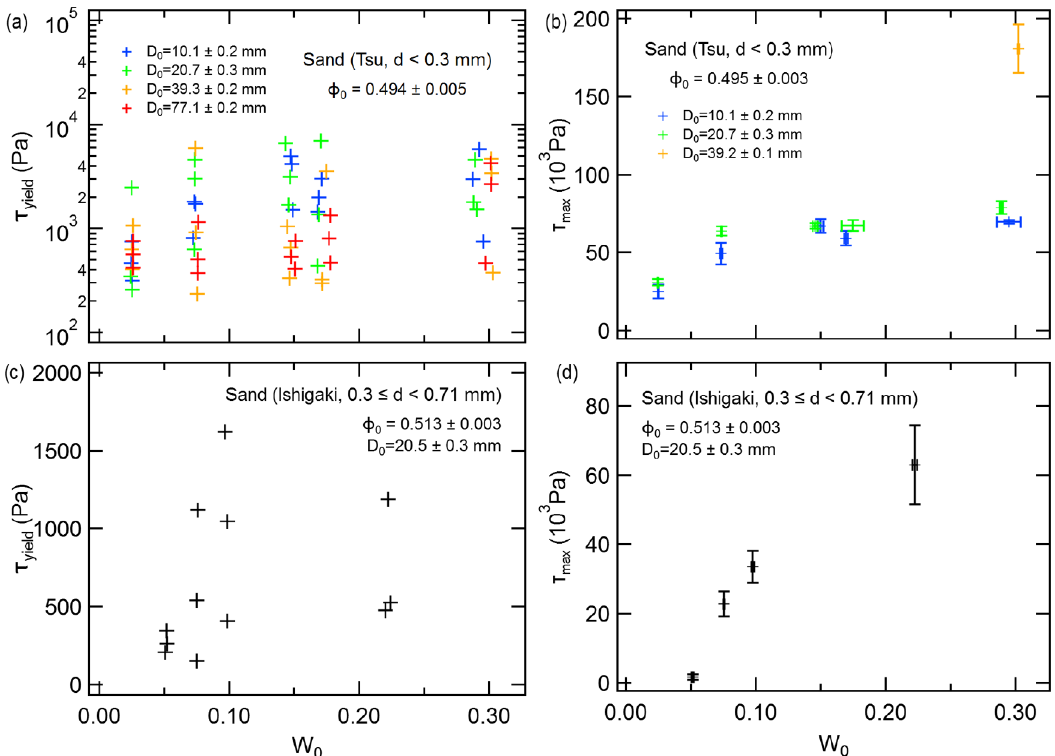
Fig 12. Effective yield stress ( τ yield ) and maximum stress ( τ max ) in wet sand of two diameters (from the Tsu and Ishigaki sites) relative to various tunnel diameters subjected to compression of overlying sand substrate. Panels: (a) Water content ( W 0 ) relationship between effective yield stress ( τ yield ) using sand collected at the Tsu site ( d < 0.3 mm) relative to various tunnel diameters D 0 , (b) water content ( W 0 ) relationship between maximum stress ( τ max ) using sand collected at the Tsu site relative to various tunnel diameters ( D 0 ), (c) water content ( W 0 ) relationship between effective yield stress ( τ yield ) using sand collected at the Ishigaki site (sand diameter 0.3 < d < 0.7 mm) relative to tunnel diameter ( D 0 ) of 20.5 ± 0.3 mm, and (d) water content ( W 0 ) relationship between maximum stress ( τ max ) using sand collected at the Ishigaki